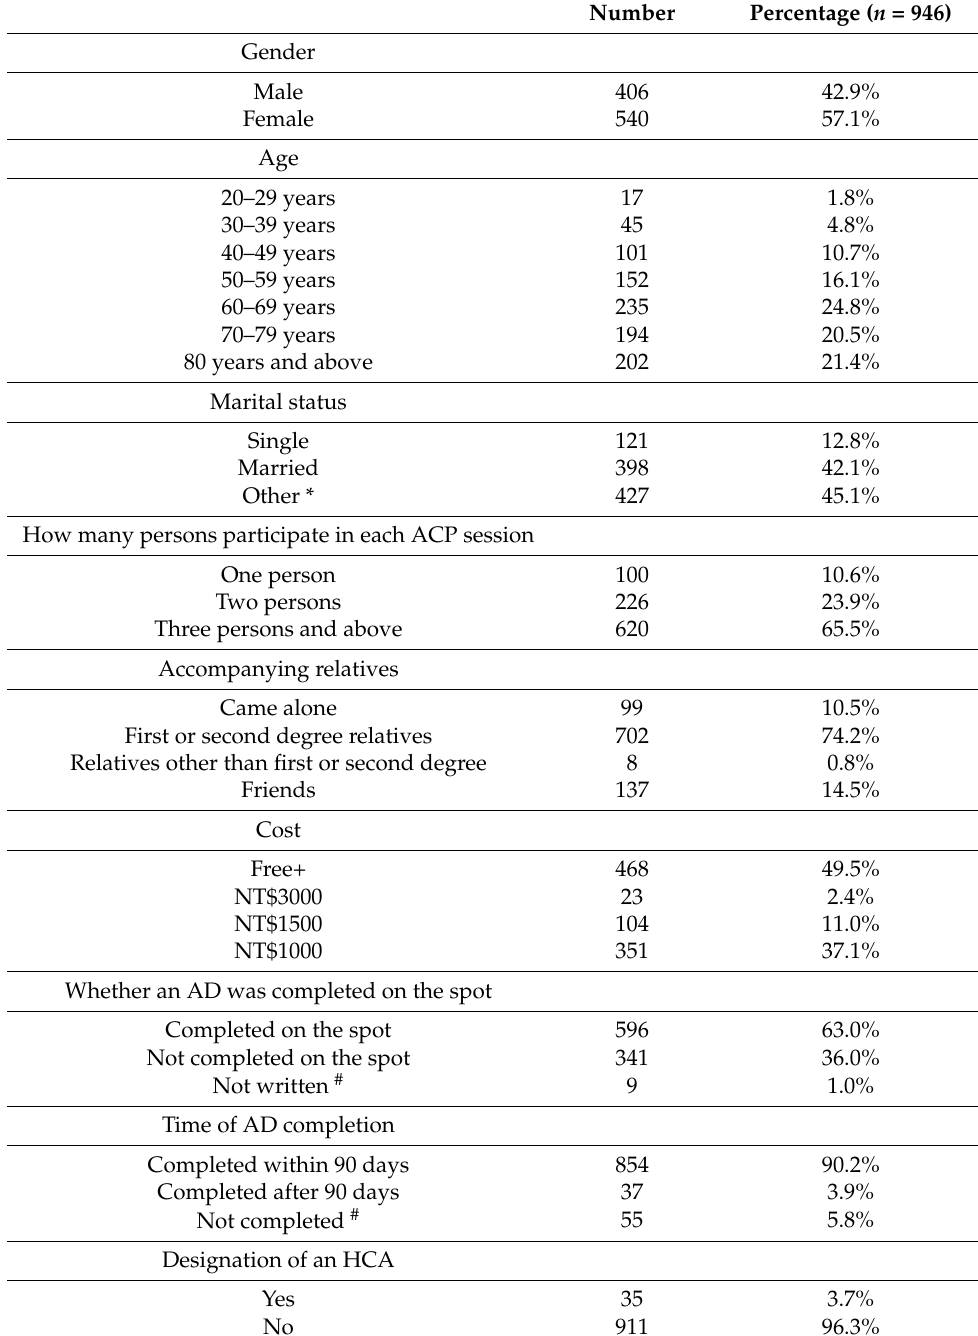
Table 1. The demographic characteristics of advance care planning participants in Taipei Veterans General Hospital in